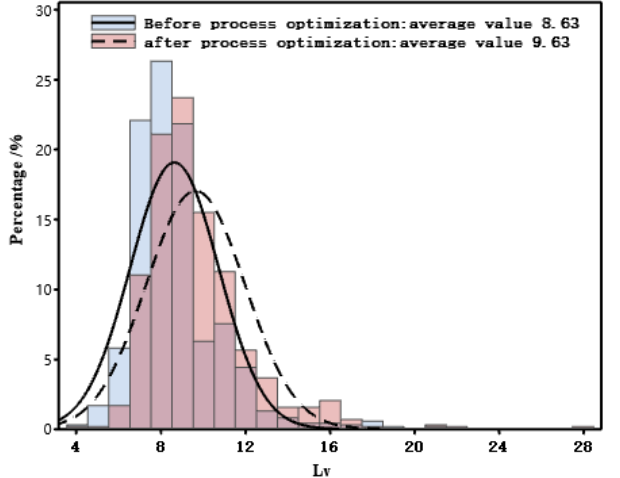
Figure 7. Comparison of vanadium distribution ratio before and after process optimization.